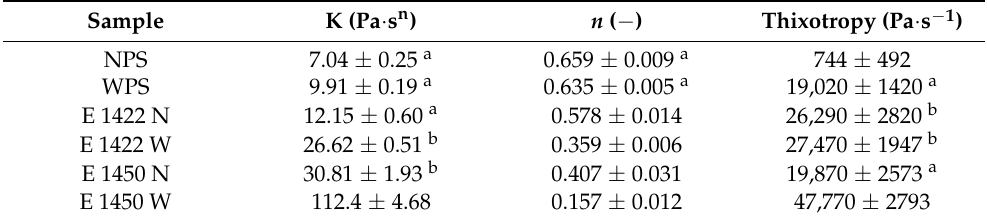
Table 1. Parameters of the Ostwald de Waele equation for pastes of aerogels of concentration of 5%.